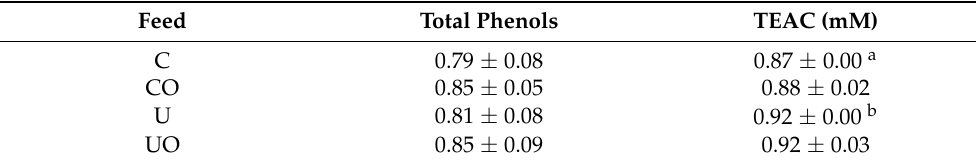
Table 6. Experiment 3. Bioactive compounds content of the experimental feeds expressed in g/100 m.s. Values presented as mean ± SD. Values in a column not sharing the same letter dif- fer significantly with p < 0.05.